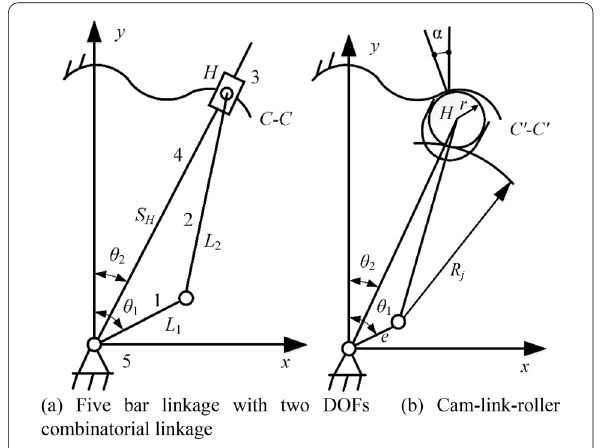
Figure 2 Schematic diagram of oscillatory roller